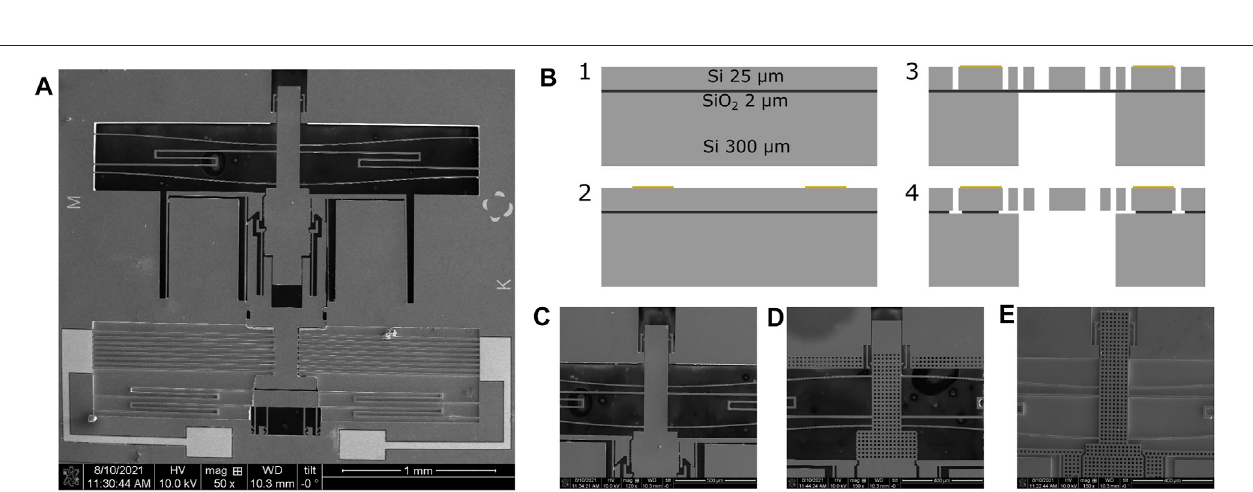
FIGURE6|(A) SEMimageforthemicrofabricatedmultistablemicrosystem.FabricationprocessbasedonSOIwafers. (B1) TheSOIhasdevice,oxide,andhandle layers with thickness values of 25 μ m, 2 μ m, and 300 μ m. (B2) A metal layer is fi rst deposited and patterned. (B3) The device and handle layers are etched using DRIE. (B4) The device is released from the oxide via HF wet etching. SEM images for the mobile part in microfabricated multistable microsystems, in which (C) the backside is completely etched, (D) the backside is partly etched at the edges and the remaining part is removed during releasing, (E) the backside is neither etched nor